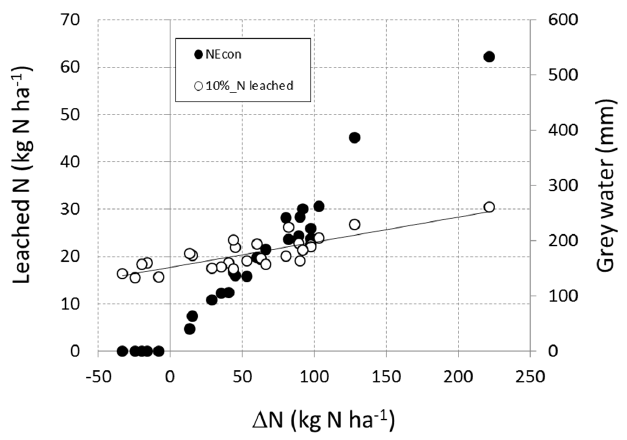
Figure 4. Relationship between ∆ N and estimated leached nitrogen (kg N ha − 1 ). ∆ N is the difference of N fertilizer supply between N Econ and N Bal = 0 . Leached N was estimated from N surplus and the leaching fraction β according to [14]. The linear regression function (10%_N leached) is the simplified approach according to [14]. Grey water footprint (mm) is expressed as dilution water demand with a threshold of 50 mg nitrate per